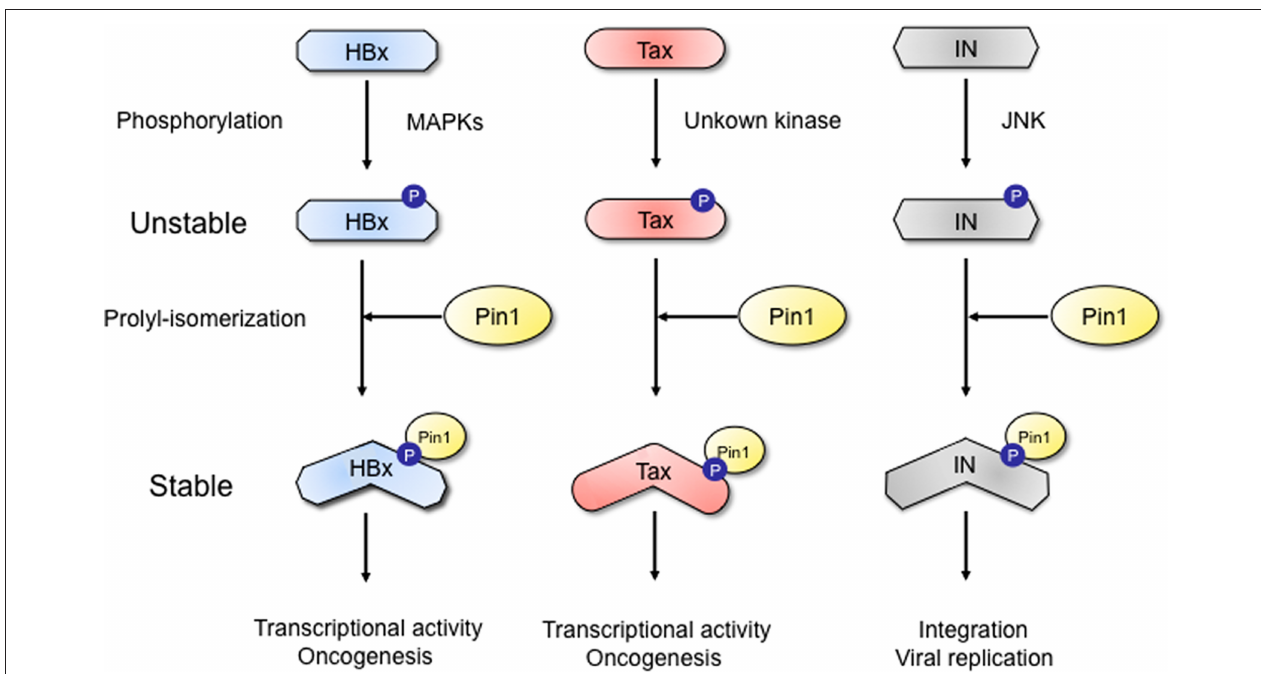
Figure 1 | A novel post-phosphorylation regulatory mechanism for viral protein stability. The phosphorylation of viral proteins (HBV HBx, HTLV-1 Tax, and HIV IN) by the proline-directed kinases (JNK, MAPK etc.) generates binding modules for Pin1. Subsequent prolyl-isomerization by Pin1 induces conformational changes and thereby enhances the viral protein